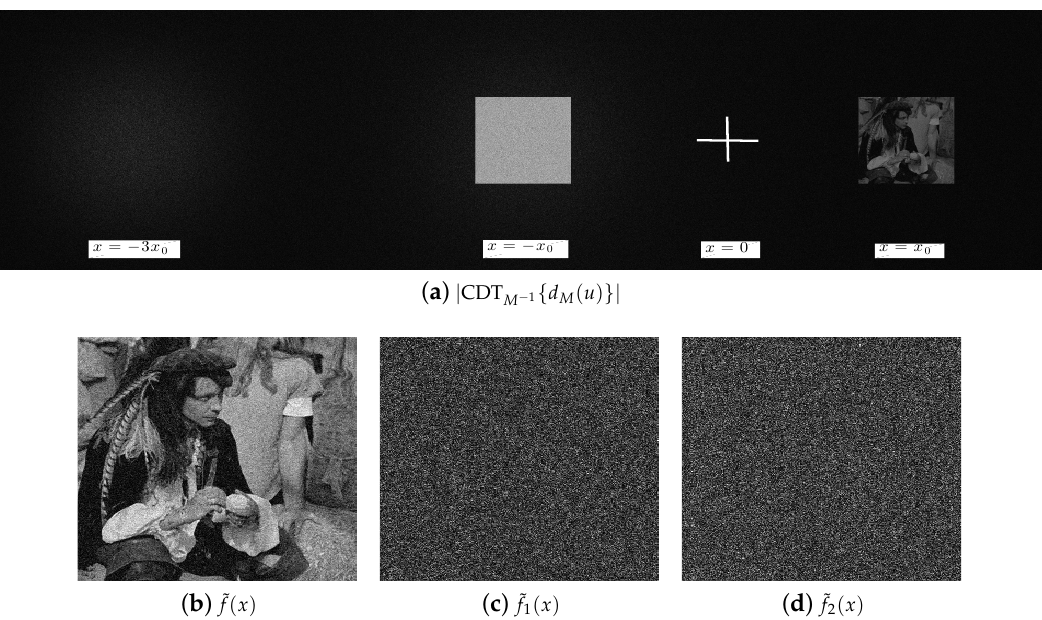
Figure 3. ( a ) Absolute value of the output plane for the decryption system with the right values of the security keys λ , l and the RPM h ( x ) . ( b ) Magnified region of Figure 3a centred at coordinate x = x 0 which is the decrypted image ˜ f ( x ) . Decrypted images when: ( c ) the security key of the decryption system given by the RPM h ( x ) is different from the RPM h ( x ) used in the encryption system and ( d ) an incorrect wavelength of λ = 575 nm is used in the decryption